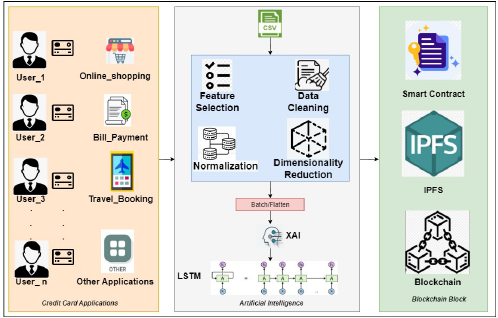
Figure 2. Architectural view of the proposed scheme ( RaKShA